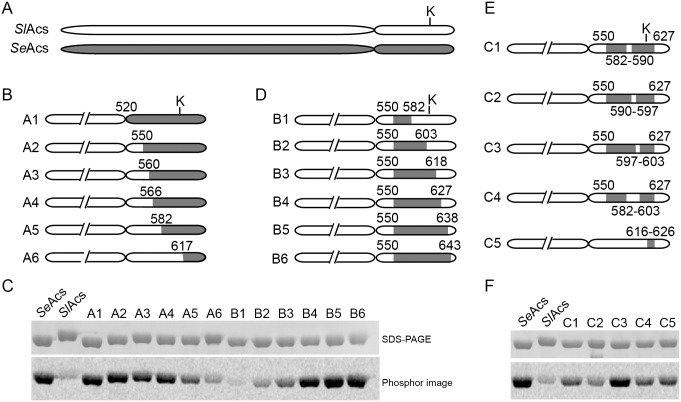
Construction and acetylation of SlAcs-SeAcs chimeras.A. A scheme of SlAcsWT (white) and SeAcsWT (grey) drawn to scale. Target lysine K610 for SlAcsWT and K609 aligned and depicted by “K”. The N-terminal domains (520 residues) are shortened with a hatch in all remaining panels. B. Schematic representation of SlAcs-SeAcs chimeras A1–A6 in which the C-terminal portion of SlAcsWT (white) was replaced with the corresponding amino acid sequence from SeAcsWT (gray). All chimeras are drawn to scale for reference to the target lysine (denoted by “K”). Numbers all denote the fusion points with respect to the SlAcs protein sequence (i.e. either the first residue of SlAcsWT replaced by SeAcsWT sequence or the first residue of SlAcsWT after the SeAcsWT amino acid sequence). C. Acetylation of SlAcs-SeAcs chimeras A1–A6 and B1–B6 using SlPatAWT and [1-14C]acetyl-CoA. D. Schematic or SlAcs-SeAcs chimers B1–B6 in which internal portion of the C-terminal SlAcs domain are replaced with the corresponding sequence from SeAcsWT. E. Schematic of chimeras C1–C5. F. Acetylation of SlAcs-SeAcs chimeras C1–C6.